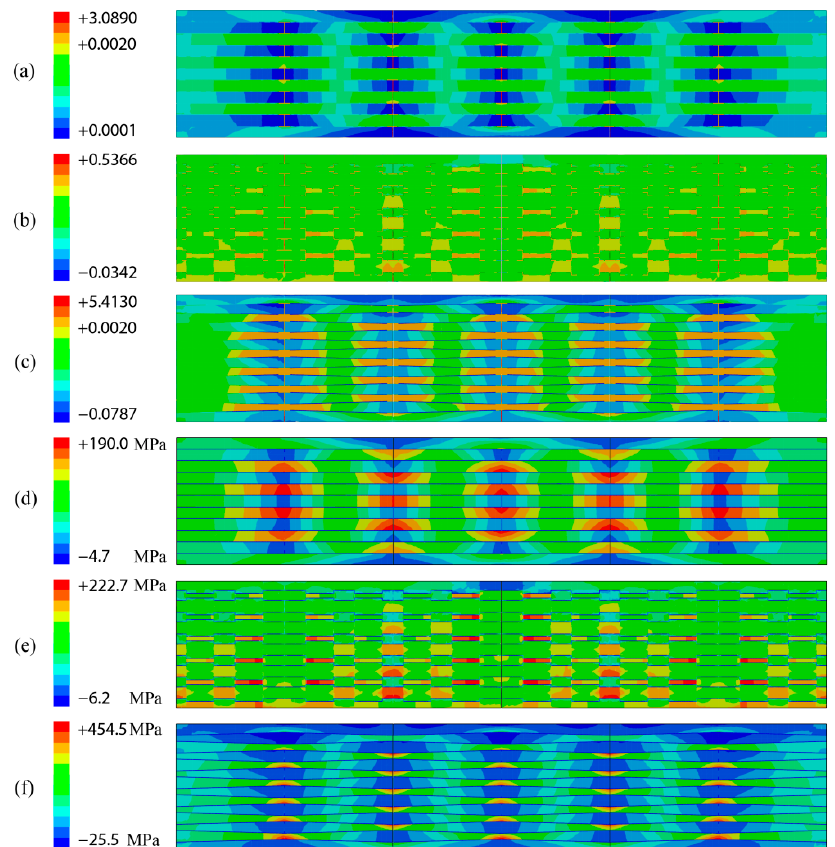
Figure 6. Horizontal stress and strain of different morphological models: ( a ) horizontal strain of the regular model, ( b ) horizontal strain of the racked model, ( c ) horizontal strain of the wedged model, ( d ) horizontal stress of the regular model; ( e ) horizontal stress of the racked model, ( f ) horizontal stress of the wedged model.